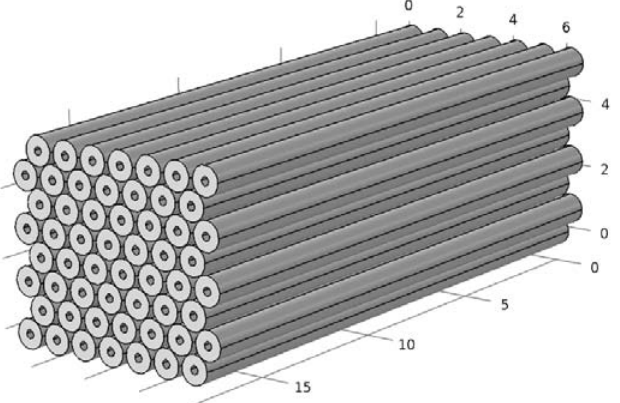
Figure 14. Close-packed array of 56 tubes, each 2.2 cm (0.875 in) in diameter and 46 cm (18 in) long. The dimensions shown on the background grid are